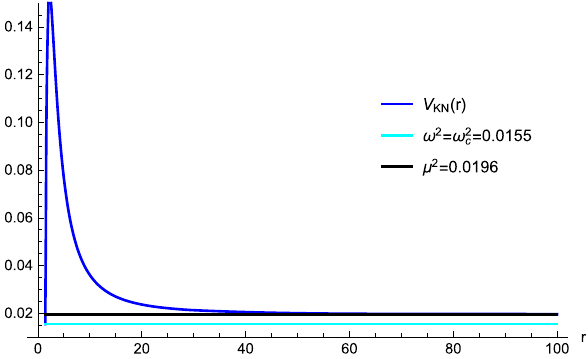
Fig. 7 Stationaryresonancepotential V KN ( r ) asfunctionof r ∈ [ r + = 1 . 4243 , 100 ] with M = 1 , Q = 0 . 9 ,ω = 0 . 1245 , a = 0 . 1 , m = 1 , q = 0 . 12 ,λ lm = 2 ,μ = 0 . 14. V KN ( r → r + ) is finite ( ω 2 = 0 . 0155). We note “ ω = ω c and ω < μ ” to meet the condition for